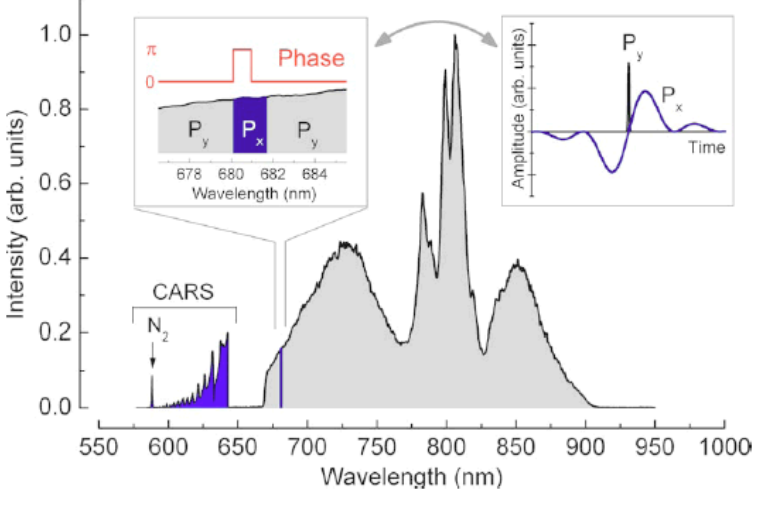
Figure 10 . Spectrum of the 7 fs laser beam and detected CARS signal from a measurement reported in [59]. In the left inset, the phase and polarization masks are shown; Px and Py correspond to orthogonal polarizations. In the right inset, the temporal profiles of the excitation and probe parts of the beam are shown along with their overlap. Reprinted from Roy et al. [59]. Copyright 2009, American Institute of